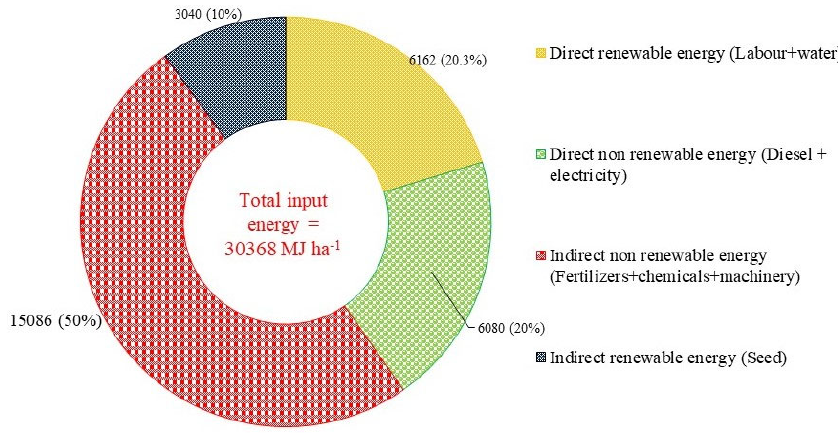
Figure 2. Input and output of energy under different management practices.